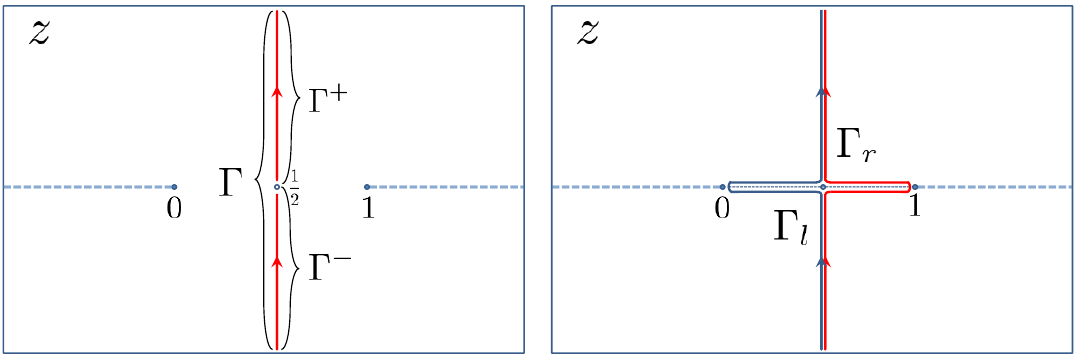
Figure 1 . Contours of integration de(cid:12)ned throughout this work. The vertical sections run along the line 1 + i R . The horizontal sections wrap around the real line segments (0 ; 1 = 2) and (1 = 2 ; 2